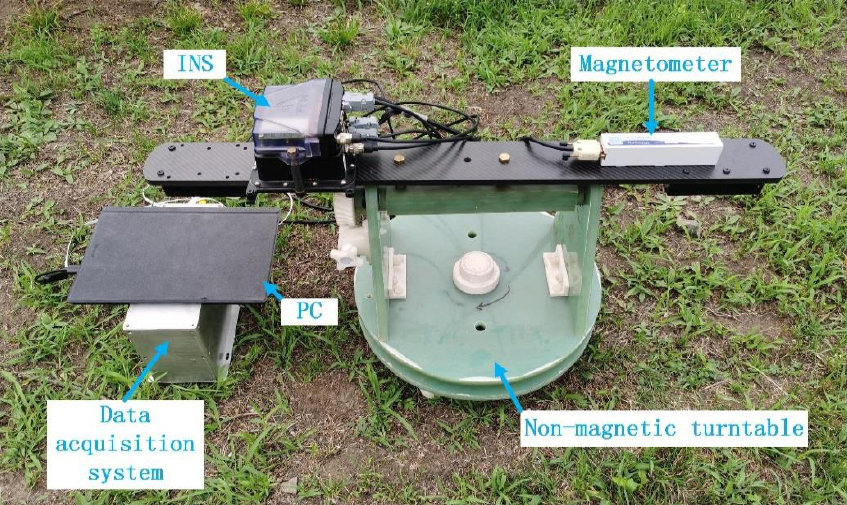
Figure 6. Diagram of experimental system.